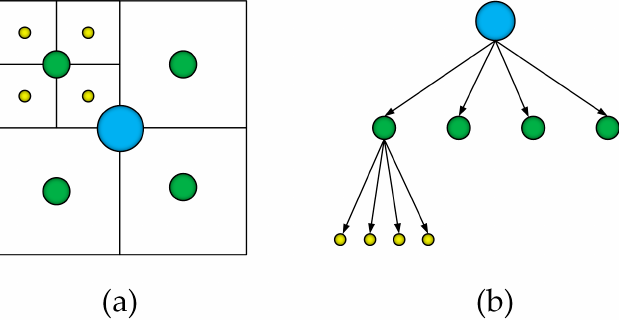
Figure 2. 2D multi-level grid storage format: ( a ) 2D multi-level grid; ( b ) quadtree storage format.